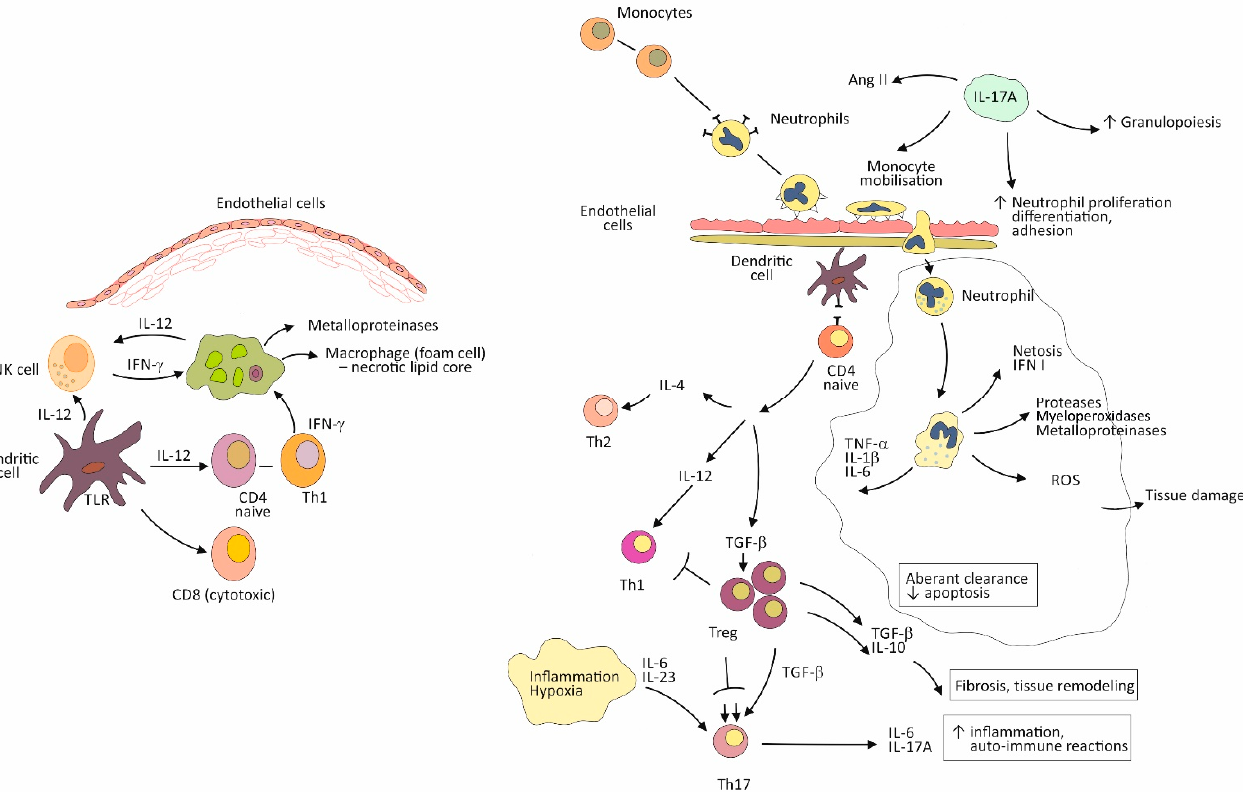
Figure 1. Immune mechanisms included in the development of cardiovascular disease that could explain variations in the neutrophil-to-lymphocyte ratio.